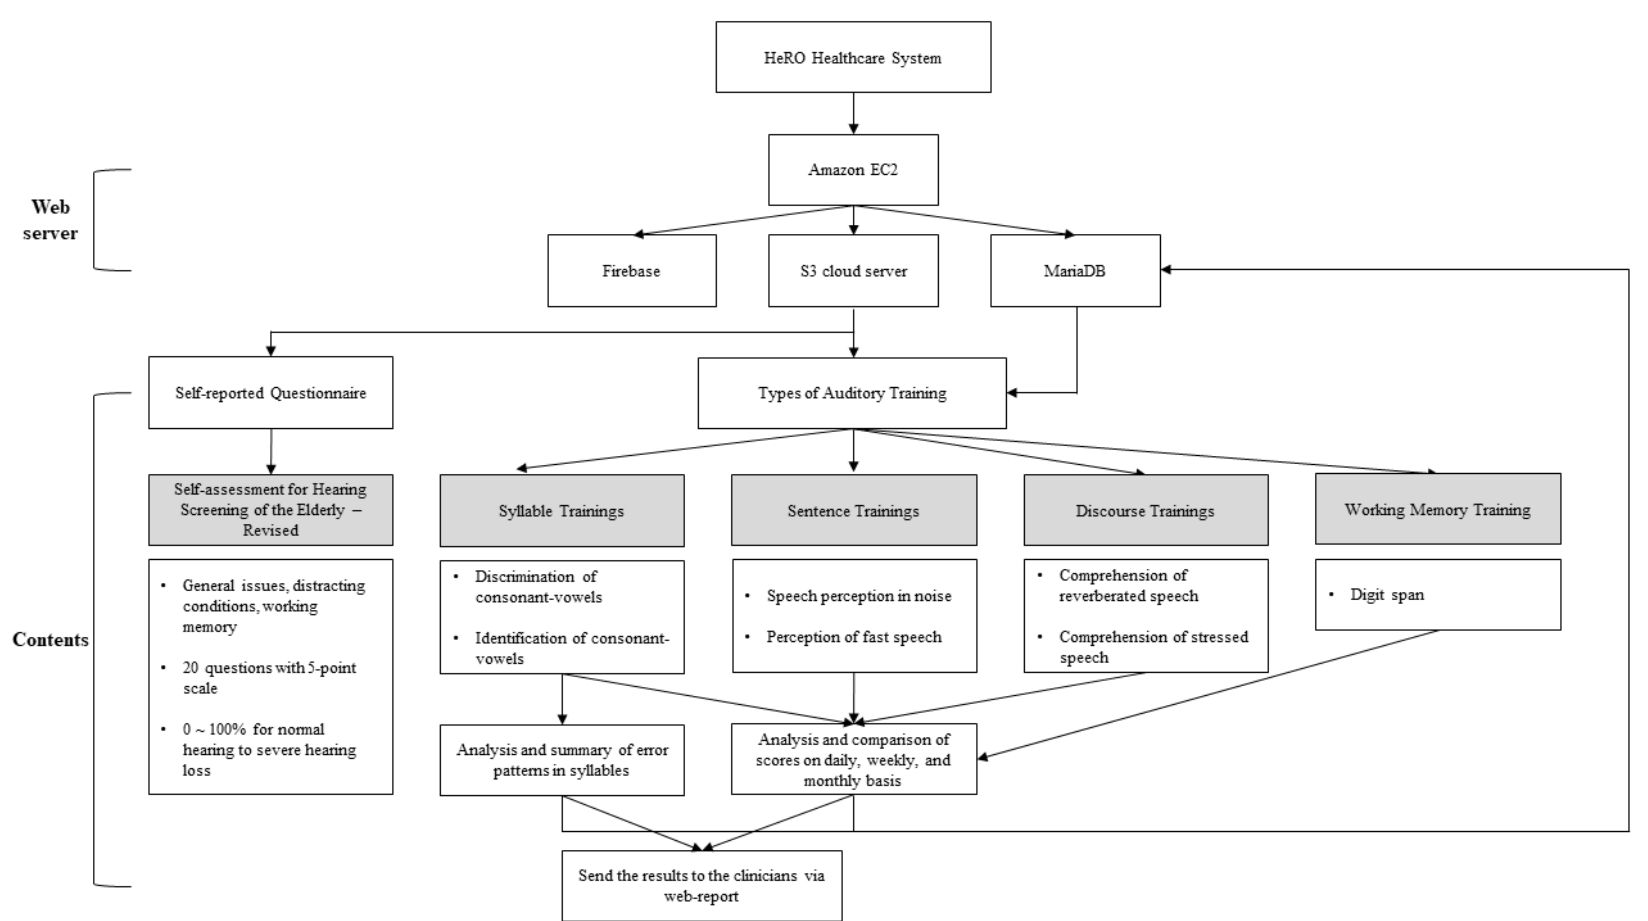
Figure 1. Framework of HeRO healthcare mobile application including web server parts and key contents, which consists of one self-questionnaire and four types of auditory training. It sends a summary of the training results to the clinician and provides feedback to the users (trainees) from the clinician as interactive communication.